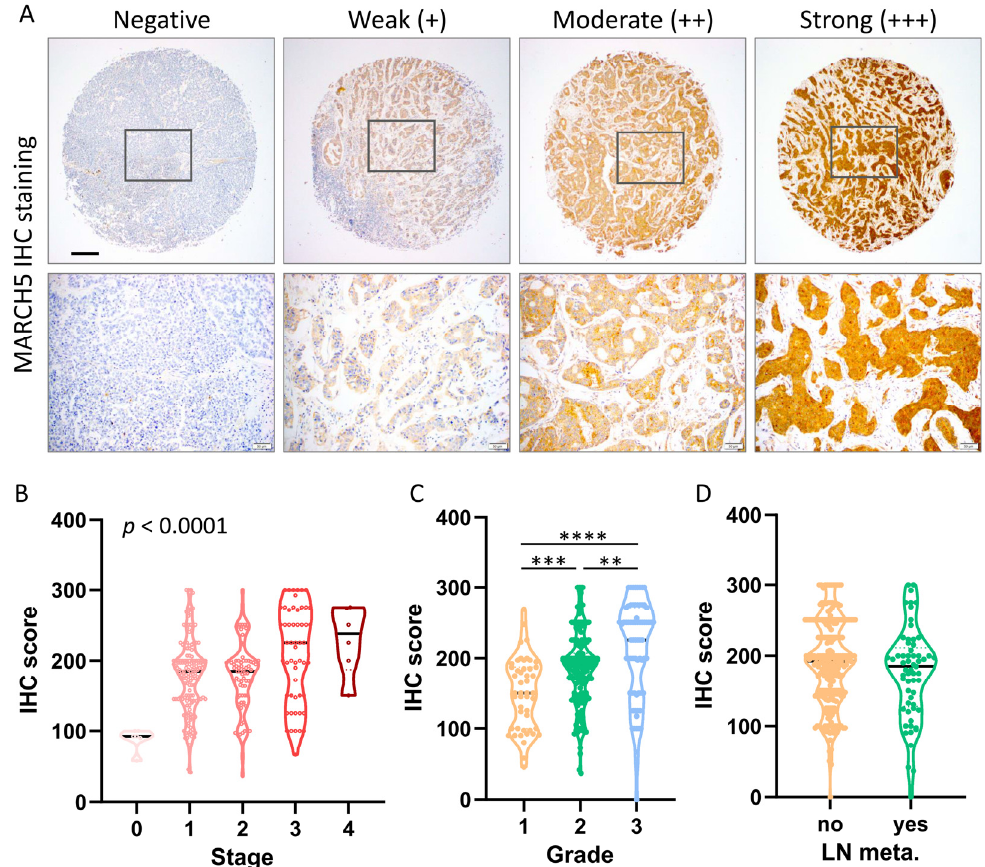
Figure 6. Protein levels of MARCH5 in breast carcinoma. ( A ) Representative images of MARCH5 staining in BRCA tissues. ( B ) IHC scores of MARCH5 expression in BRCA tissues. ( B–D ) Violin plots of MARCH5 expression levels BRCA with significant alterations in different stages, grade, and lymph node metastasis. ** p < 0.01, *** p < 0.001, and **** p < 0.0001. Scale bar = 200 μ m.